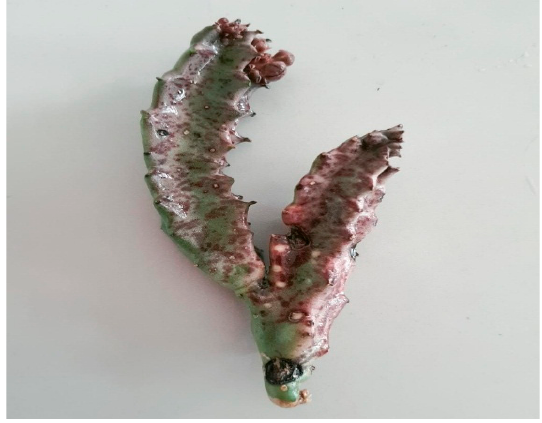
Figure 1. An aerial part of C. europaea .